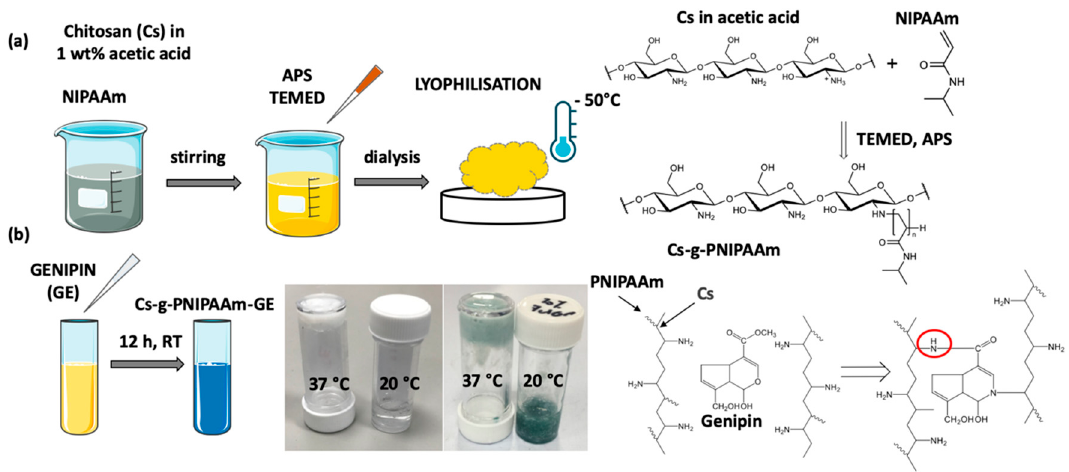
Figure 1. ( a ) Schematic of Chitosan-grafted-Poly(NIPAAm) synthesis. ( b ) Crosslinking of Cs-g-PNIPAAm with genipin (GE).